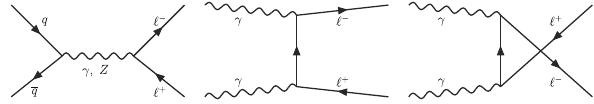
Fig. 1 Diagrams that contribute to lepton-pair production at hadron colliders at the Born